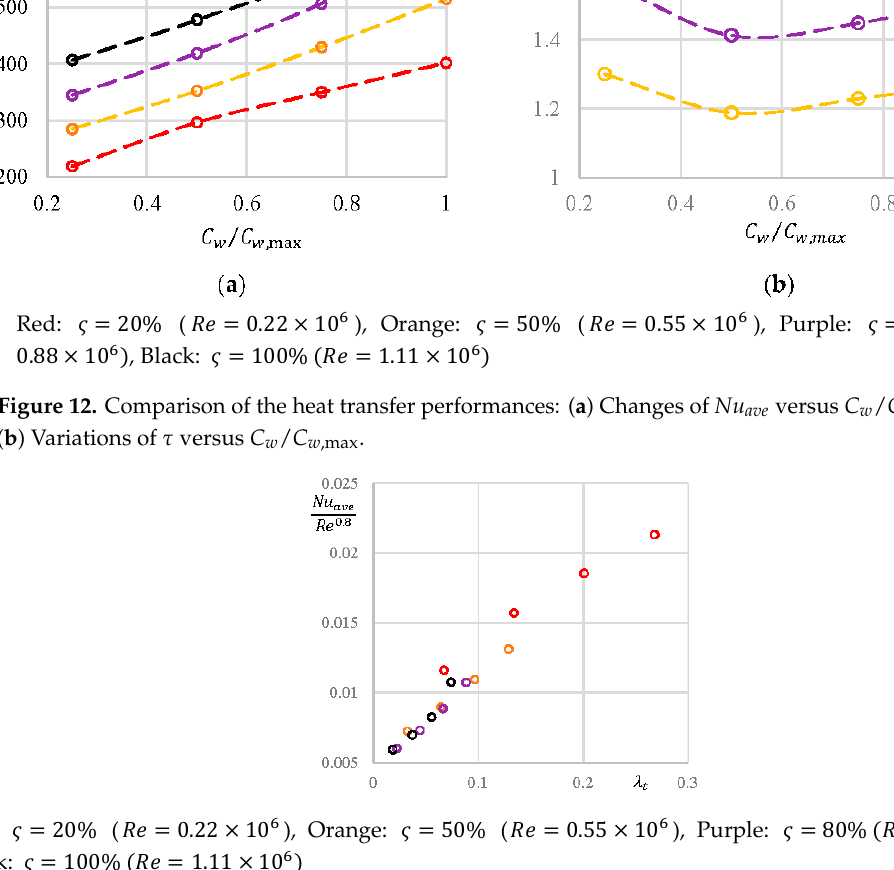
versus 𝜆 (cid:3047) . Figure 13. Variations of Nu ave versus λ t (cid:3019)(cid:3032) (cid:3116).(cid:3124) Re 0.8